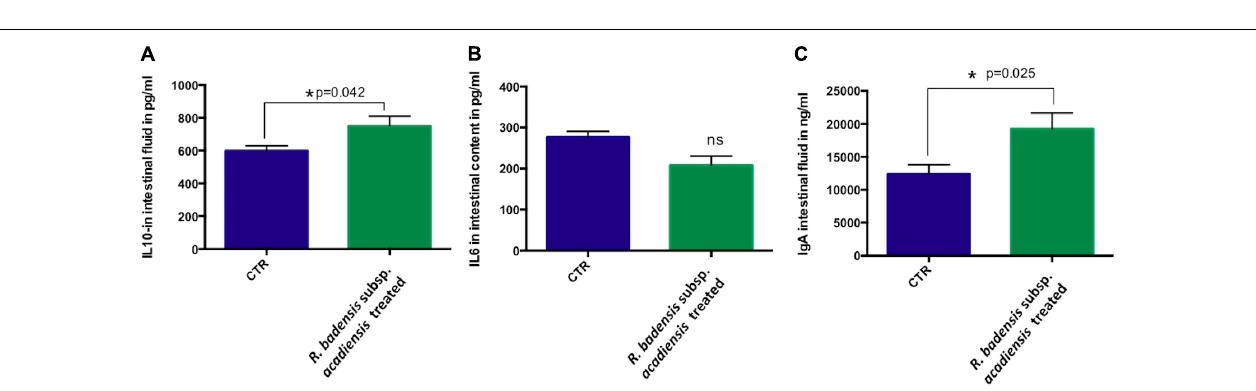
FIGURE 7 | Mean ± SEM of the number of goblet cells stained with AB (Alcian Blue) at pH 2.5 in 10 fields of objective 100 × in the small intestine of mice fed 1% sucrose (CTR) or R. badensis subsp. acadiensis fed 10 8 CFU/mouse/day for 7 days. Significant difference exists if * p < 0.05-Representative tissue photos are taken with objective 10 × , 20 × , and 40 × magnifications of the PAS-stained tissue. AB stains in blue acid glycoconjugates.